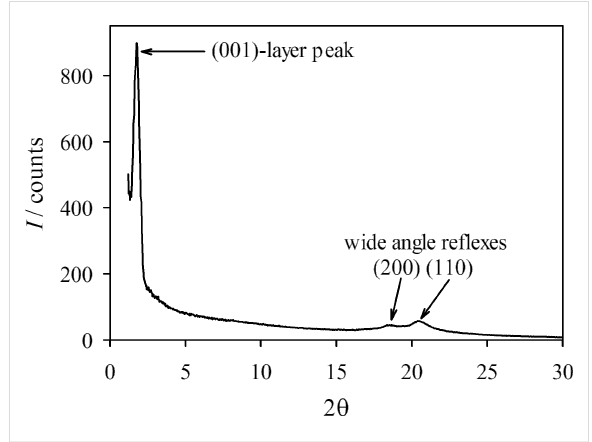
Figure 9: Integrated intensity profile of an unoriented sample of PhP16 at T = 82.5 °C in the SmF phase.